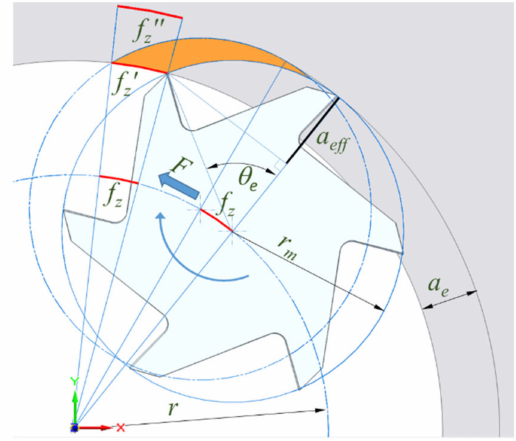
Figure 5. Engagement angle and chip depth in the interior